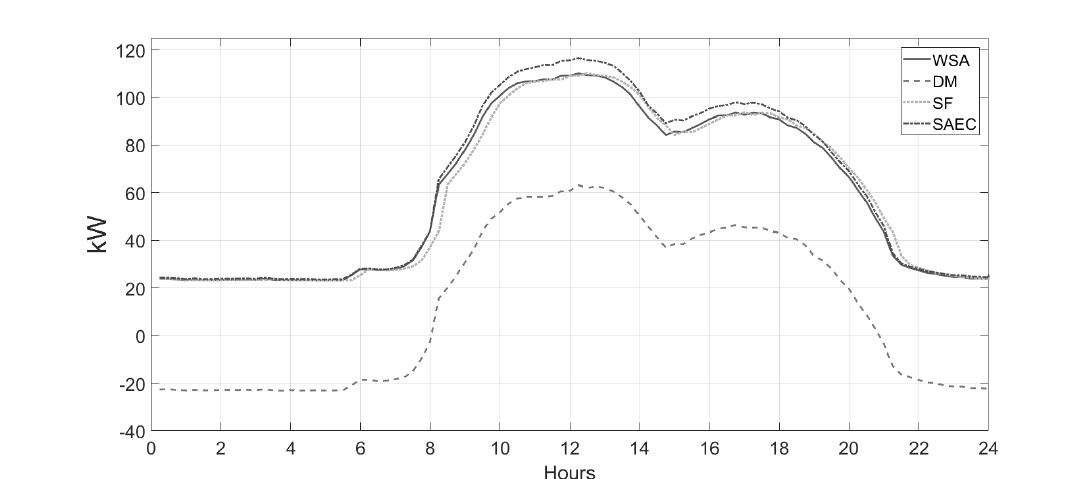
Figure 8. Mean of the consumption patterns.